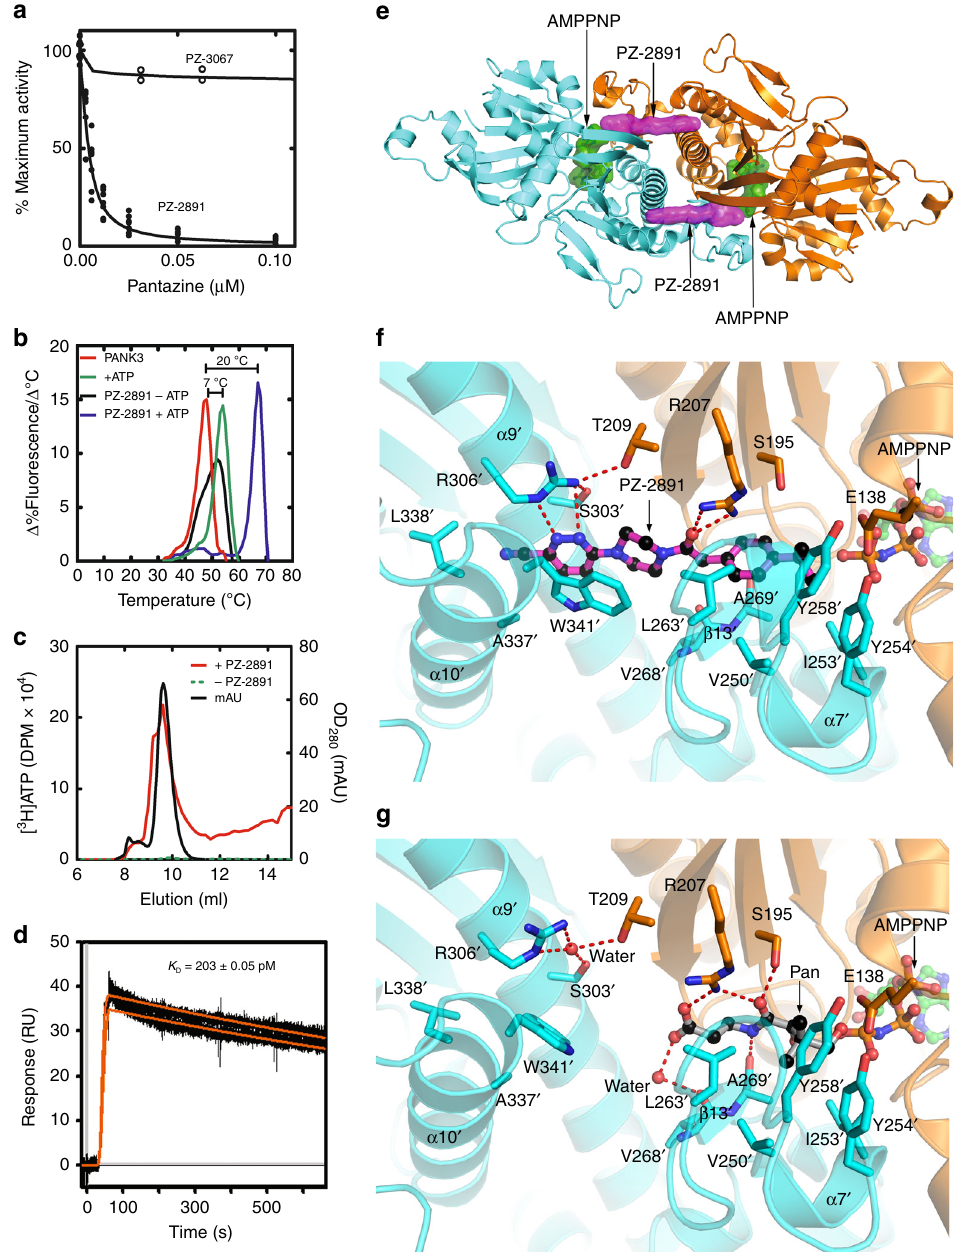
Fig. 2 PZ-2891 binds to the PANK3 (cid:129) ATP (cid:129) Mg 2 + complex with nM af fi nity. a PZ-2891 ( n = 10) ( fi lled circles) and PZ-3067 (open circles) ( n = 2) inhibition of PANK3. The data were fi t to the Morrison equation and 1.3 ± 0.2 nM was the consensus PZ-2891 IC 50 from fi ve experiments using different batches of puri fi ed enzyme. A representative data set is shown. b Thermal stabilization of PANK3 by 8 mM ATP, 8 μ M PZ-2891 or 2 mM ATP plus 2 μ M PZ-2891. Control (red line), PZ-2891 (black line), ATP (green line), and ATP plus PZ-2891 (blue line). The peaks of the fi rst derivative plots of the thermal denaturation curves identify the temperatures at which 50% of the protein is unfolded. The shifts in the thermal denaturation temperatures were calculated from experiments performed in triplicate, and the averages rounded to the nearest degree. c Isolation of the PANK3 (cid:129) [ 3 H]ATP (cid:129) Mg 2 + (cid:129) PZ-2891 complex by gel fi ltration chromatography. Black trace, PANK3 protein elution pro fi le (A 280 ); Red trace, [ 3 H]ATP elution pro fi le in the presence of PANK3 + PZ2891; Green trace (on baseline), [ 3 H]ATP elution pro fi le with PANK3 alone. One example of duplicate experiments is shown. d Surface plasmon resonance analysis of PZ-2891 binding to PANK3 in the presence of 1 mM ATP (cid:129) Mg 2 + . The data (black lines) were fi t to a 1:1 binding model (orange lines). The association ( k a ), dissociation ( k d ), equilibrium ( K D ) constants were calculated as 2.37 × 10 6 M -1 s -1 , 4.82 × 10 – 4 s -1 and 0.203 nM respectively. The residence time (1/ k d ) of PZ-2891 was 34 min. Data are the average of two experiments in duplicate. e Overview of the PANK3 dimer illustrating that PZ- 2891 binds across the dimer interface. The two PANK3 protomers are colored cyan and gold, PZ-2891 is purple and AMPPNP is green. f Close-up view of PZ-2891 bound across the dimer interface of the PANK3 (cid:129) AMPPNP (cid:129) Mg 2 + complex illustrating the key hydrogen bonding interactions (dotted red lines) with both PANK3 protomers. g Structure of the PANK3 (cid:129) AMPPNP (cid:129) Mg 2 + (cid:129) pantothenate (Pan) complex (PDB ID: 5KPR) with the pantothenate